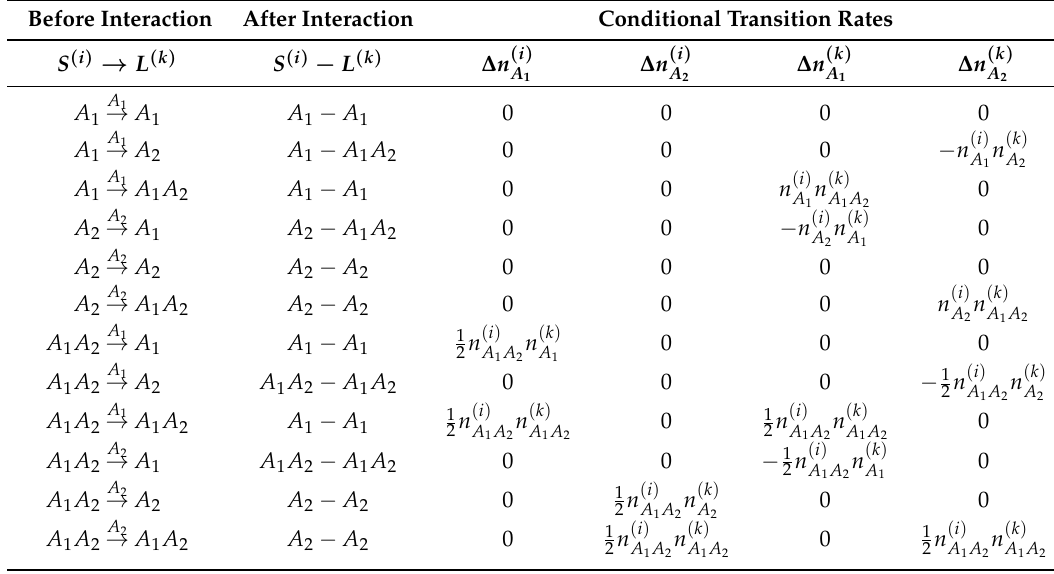
Table 1. Conditional transition rates for speaker-listener interactions. Labels S ( i ) and L ( k ) denote respectively